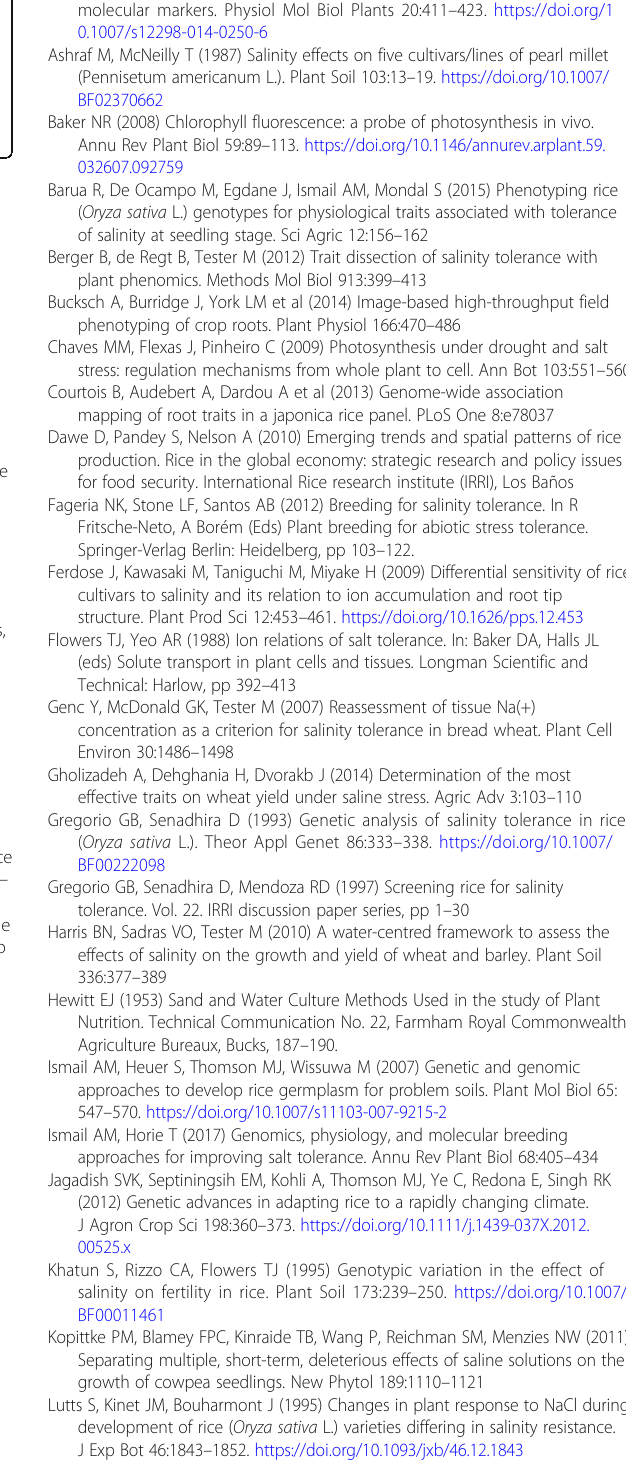
measured 37days after sowing for control (C), moderate salt stress (MSS) and high salt stress (HSS). Each value represents the mean of four replications. Table S3. Total root length, longest root length, root surface area, average diameter, and root volume of 74 rice genotypes under control (C), moderate salt stress (MSS) and high salt stress (HSS) measured 37days after sowing. Each value represents the mean of four replications. Table S4. Root tips, forks, and crossings of 74 rice genotypes under control (C), moderate salt stress (MSS) and high salt stress (HSS), measured 37days after sowing. Each value represents the mean of four replications. Table S5. Chlorophyll, flavonoids, anthocyanin, and nitrogen balance index of 74 rice genotypes under control (C), moderate salt stress (MSS) and high salt stress (HSS), measured 37 days after sowing. Each value represents the mean of four replications. (DOCX 72